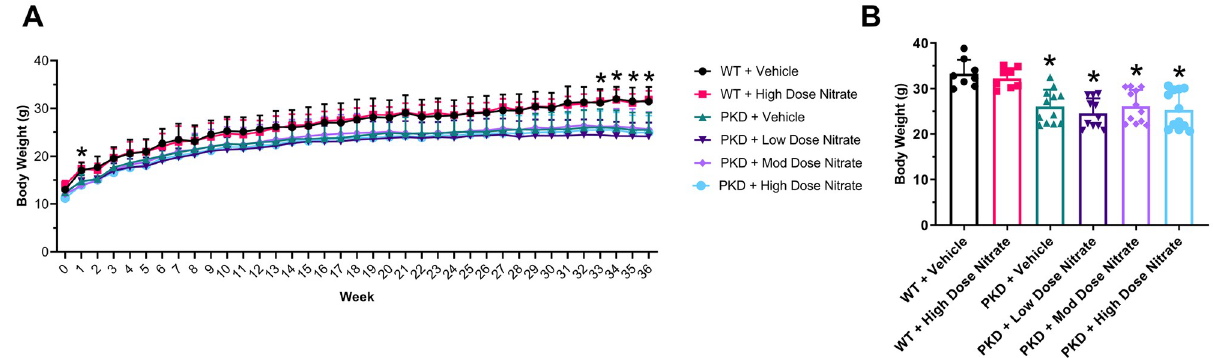
Fig 3. Body weight in wild-type (WT) and Pkd1 RC/RC (PKD) mice treated with sodium chloride (vehicle) or sodium nitrate (low, 0.1 mmol/kg/ day; moderate, 1 mmol/kg/day; high dose, 10 mmol/kg/day) for 8 months. (A) Time-course of body weight. � P < 0.05 by one-way ANOVA; (B) Body weight at 9 months of age. � P < 0.05 compared to WT + Vehicle by one-way ANOVA, followed by post-hoc analysis with the Tukey Kramer HSD test. Data were combined from male and female mice (n = 4–6 per group per gender) and presented as means ± SD.